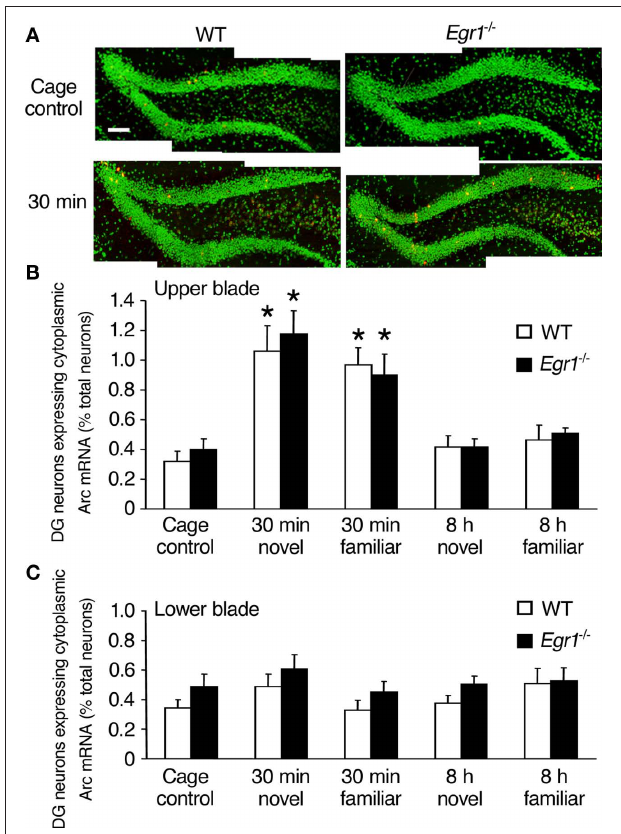
FIgure 4 | Arc mrNA expression after spatial exploration in the dentate gyrus (Dg) of WT and Egr1 − / − mice. (A) Representative images of dentate gyrus sections from WT and Egr1 − / − cage control mice and 30 min after exploration of a novel or familiar environment. Scale bar, 300 μm. Cell nuclei appear in green (Sytox) and Arc mRNA signal in red (or yellow in the nucleus). (B,C) Proportion of neurons expressing Arc mRNA in the upper (B) and the lower blade (C) of the dentate gyrus after exploration of a novel or familiar environment. In the upper blade, Arc mRNA expression was similarly induced in WT and Egr1 − / − mice 30 min, but not 8 h following exploration of a novel or a familiar environment. *Different from cage controls of the same genotype, at least p